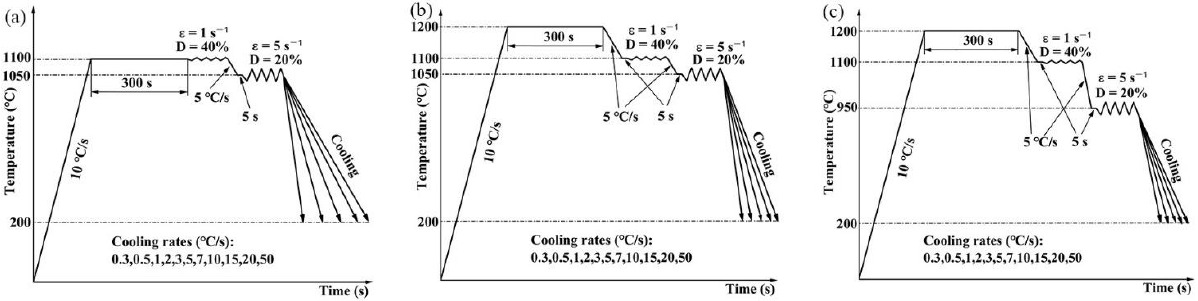
Figure 1. Thermal simulation experiment process of ( a ) Nb-1, ( b ) Nb-2, ( c ) Nb-3.